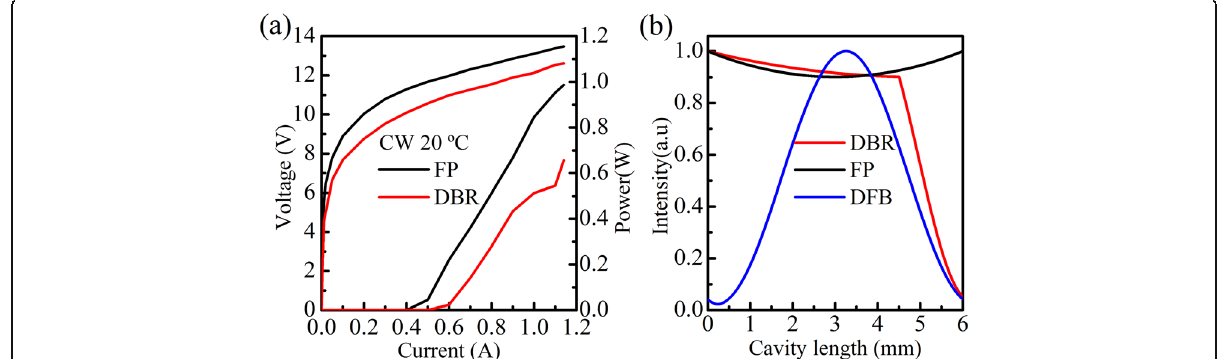
Fig. 6 a The red curve is the CW power – current – voltage (P – I – V) curve of DBR laser, the black curve is CW power – current – voltage (P – I – V) curve of the Fabry-Perot (FP) resonator cavity. b The simulated optical field distribution of DBR, FP and DFB lasers with the same cavity length of 6